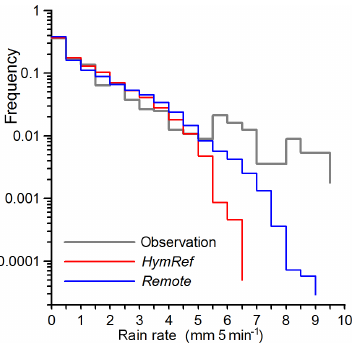
Figure 12. Normalized occurrence of the 5min rain rate determined from 31 rain gauge observations (black line) and simulations in the third domain for HymRef (red line) and Remote (blue line).